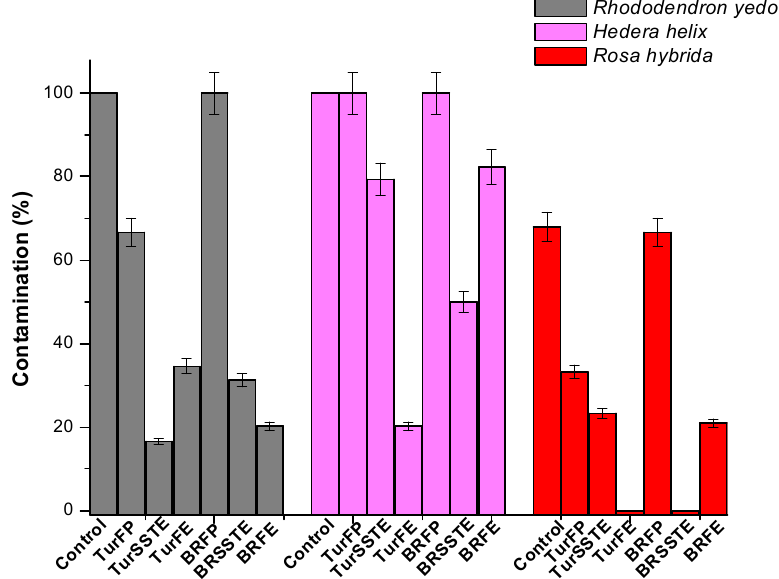
Figure 2. Graph showing results of the surface sterilization effect following